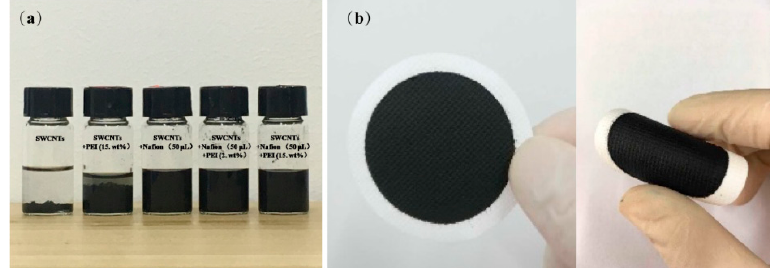
Figure 1. Photograph of SWCNT dispersions containing PEI or Nafion ( a ) and the SWCNT/PEI composite containing 2.0 wt.% PEI ( b ).